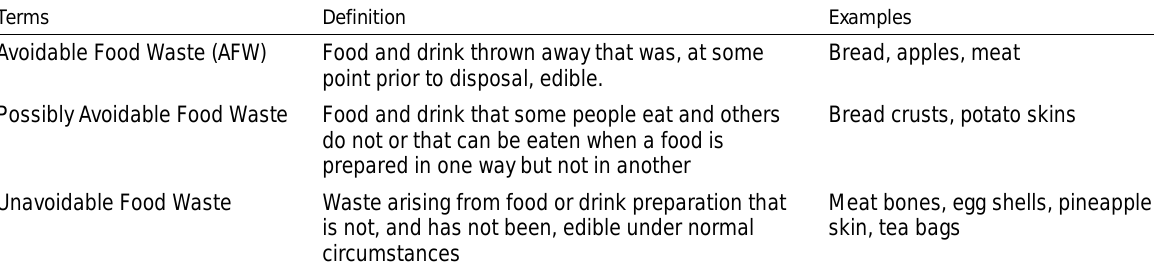
Table 1. Definitions of Household Food Waste